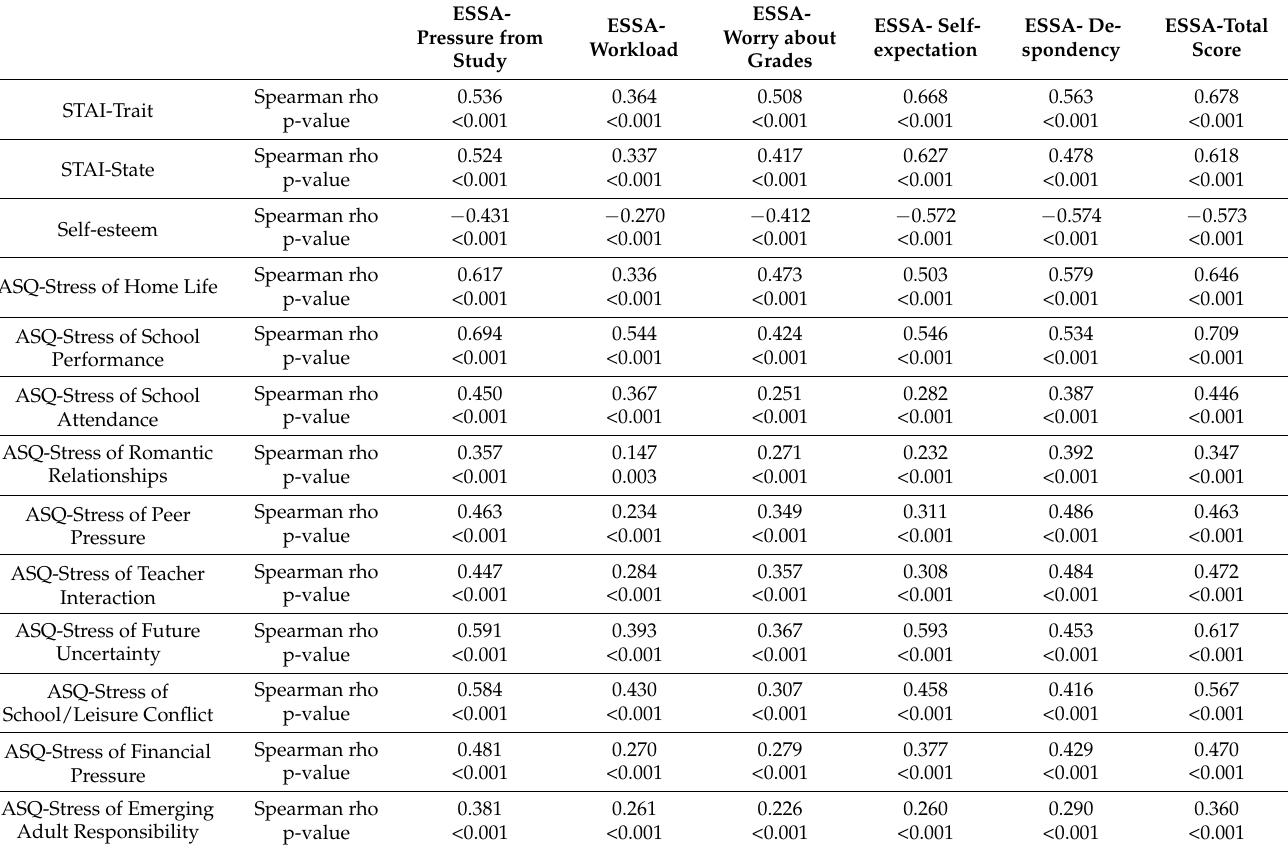
Table 6. Correlations (Spearman rho) between ESSA and STAI, self-esteem and ASQ